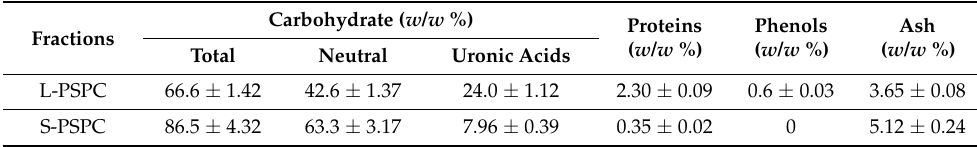
Table 1. Biochemical composition of L-PSPC (leaves) and S-PCPC (seeds).